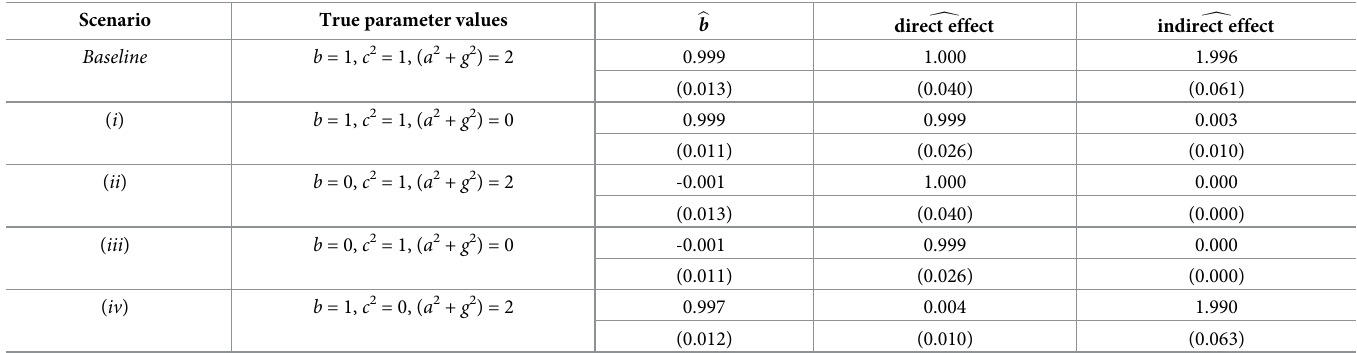
Table 2. Average estimates and corresponding standard errors of estimated parameters in the mediation model (100 simulation runs for each scenario). b b is the esti- mator of b based on Eq 8 (i.e., the effect of mediator M on outcome Y ); d direct effect is an estimator of c 2 based on Eq 10 (i.e., the genetic variance of Y that is not mediated by M